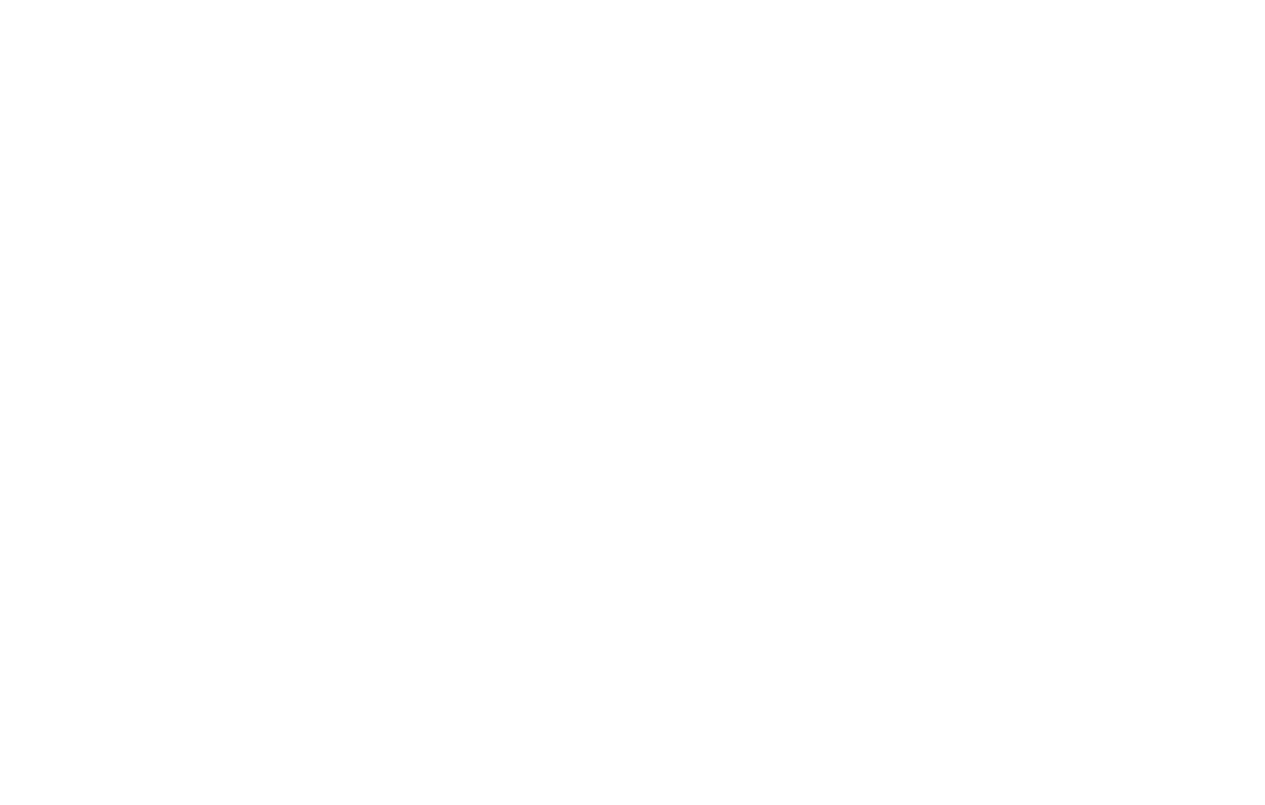
Frontiers in Ecology and Evolution | www.frontiersin.org